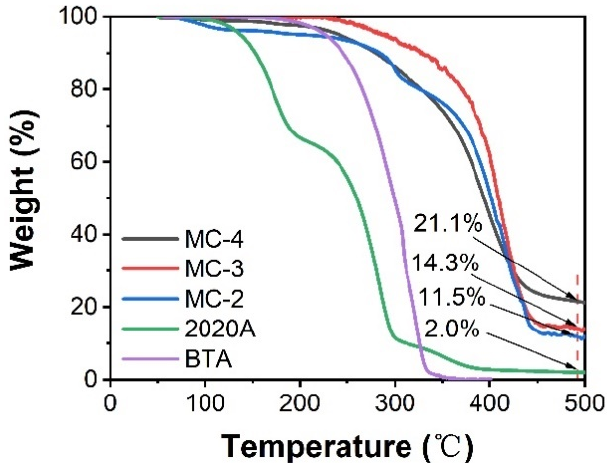
Figure 3. The TGA spectra of the BTA, 2020A, and GO microcapsules.